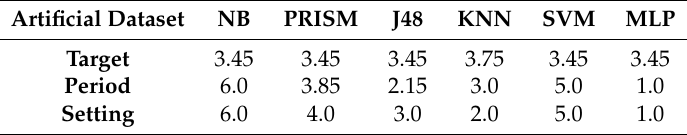
Table 10. Average ranking